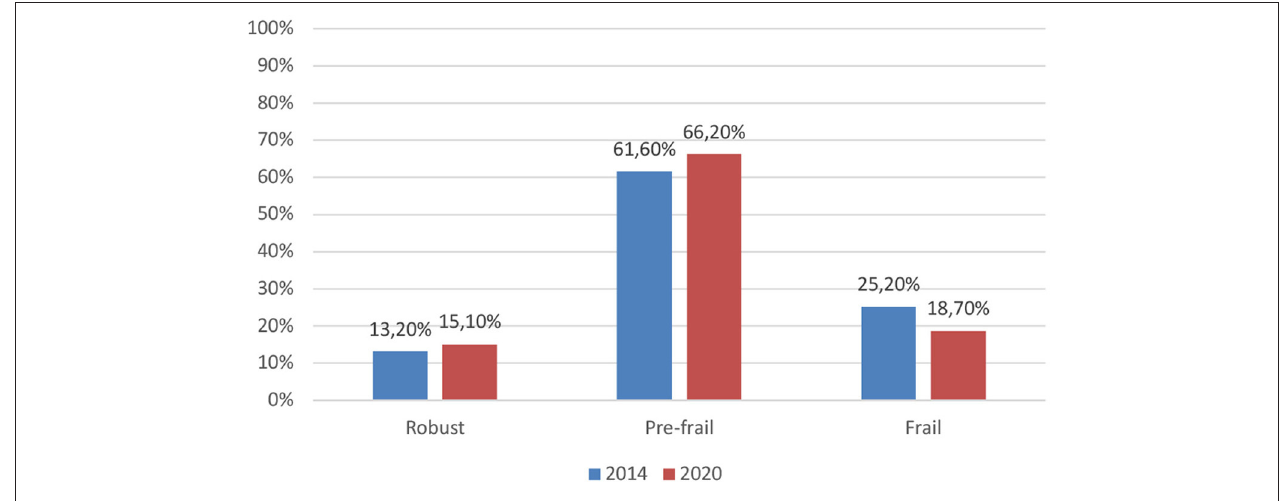
FIGURE 1 | Prevalence of frailty among Indonesian elderly in 2014 and 2020.